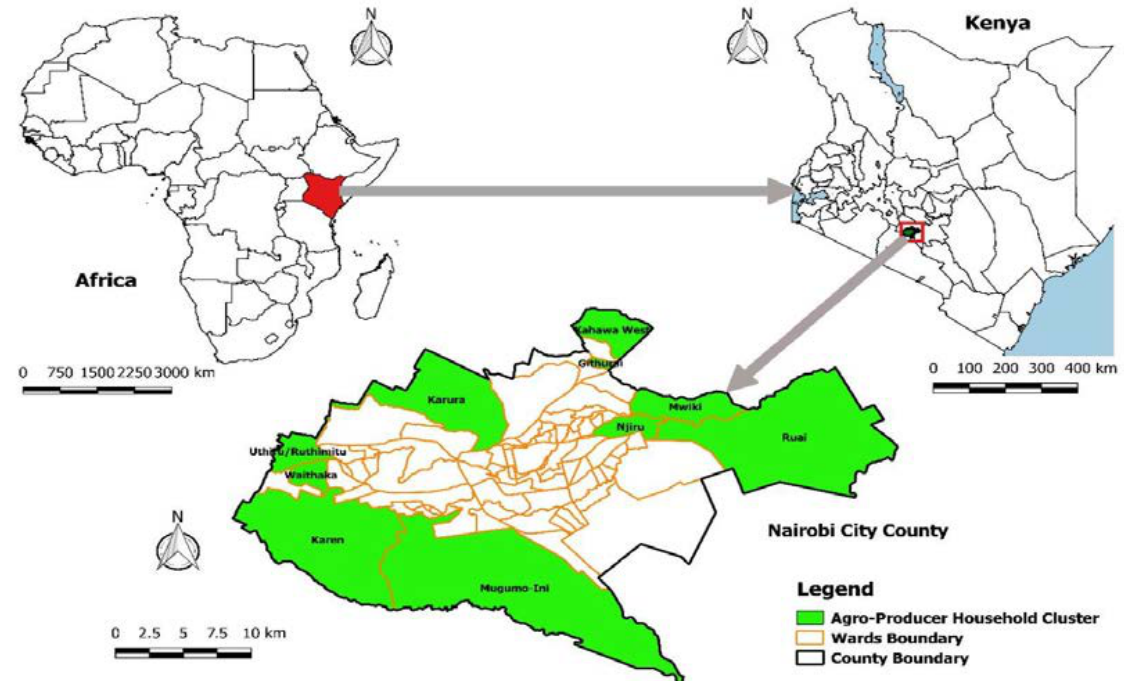
Fig. 1: Geographic location of the study area, Nairobi City County in Kenya